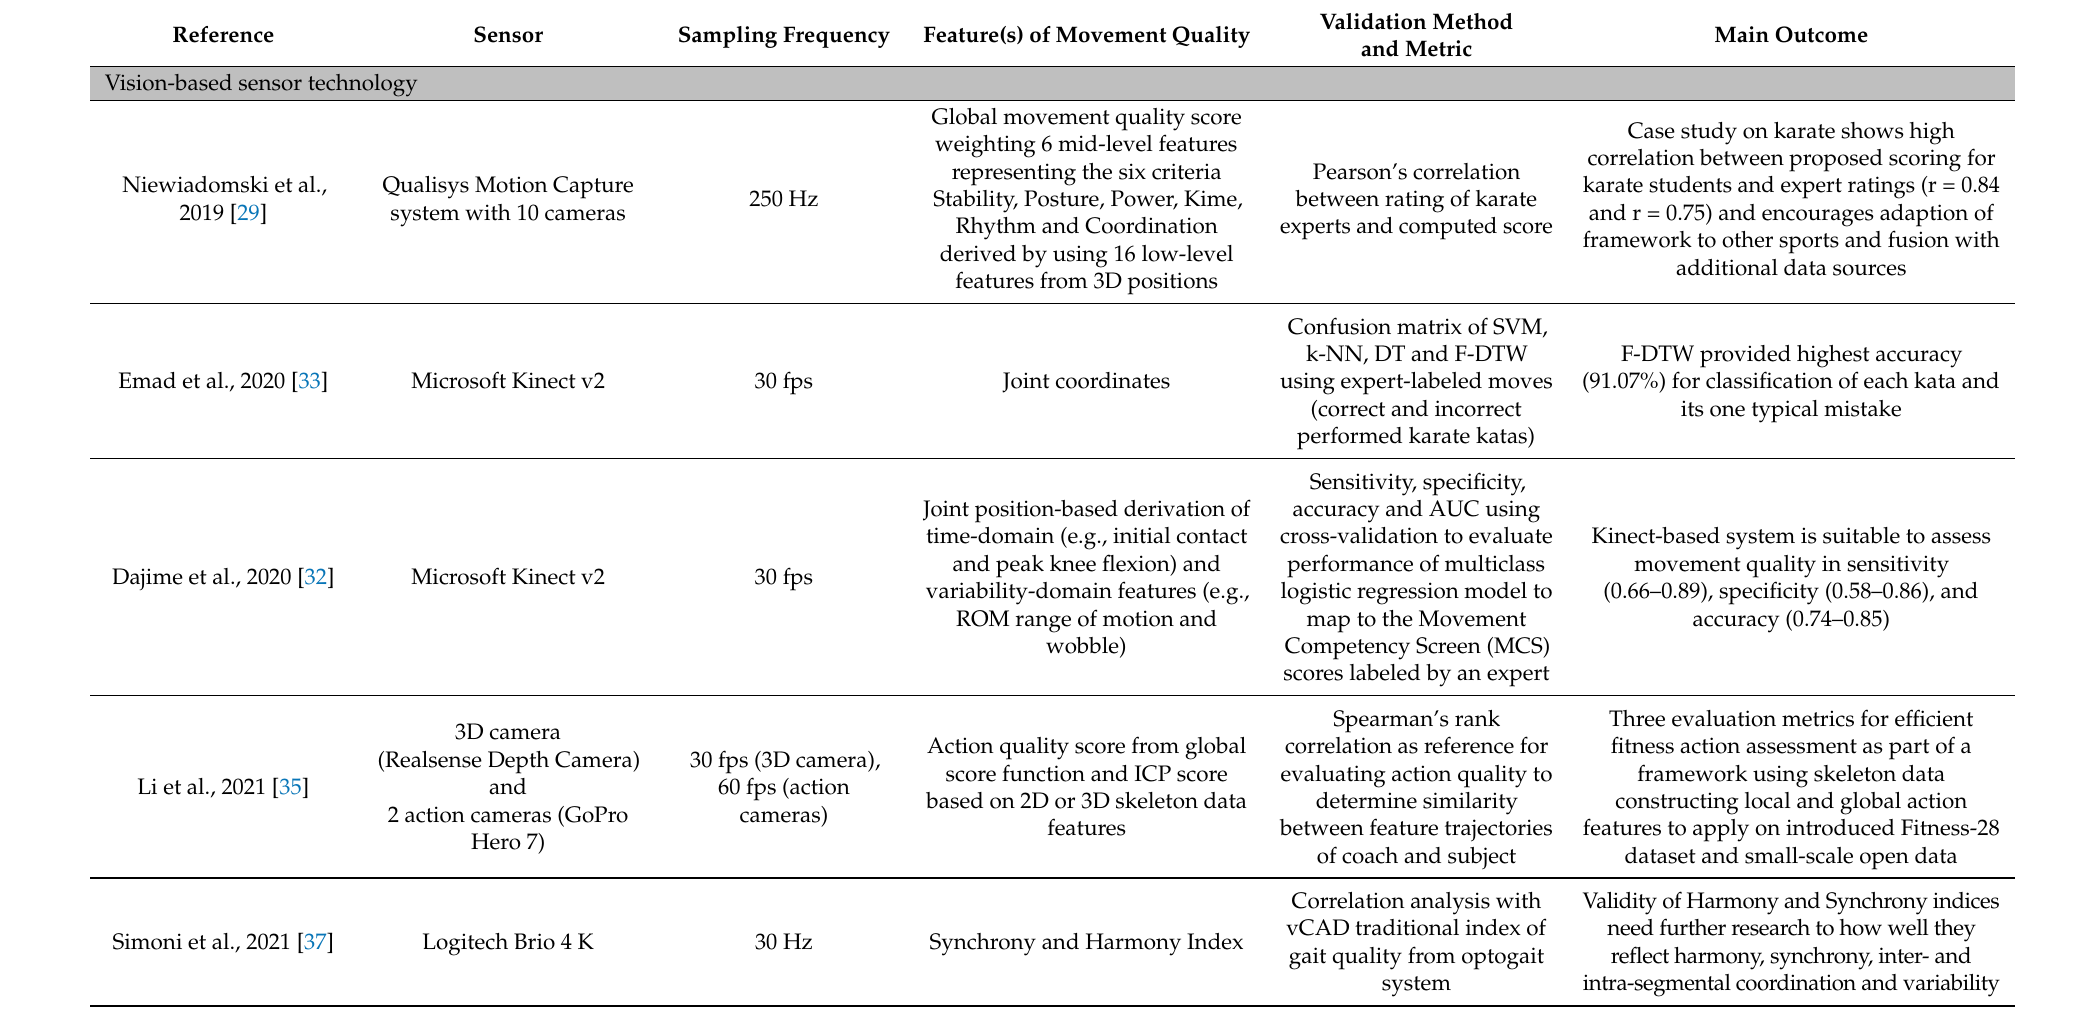
Table 2. Used sensor technologies, quality features and main outcomes of the assessments ( n =